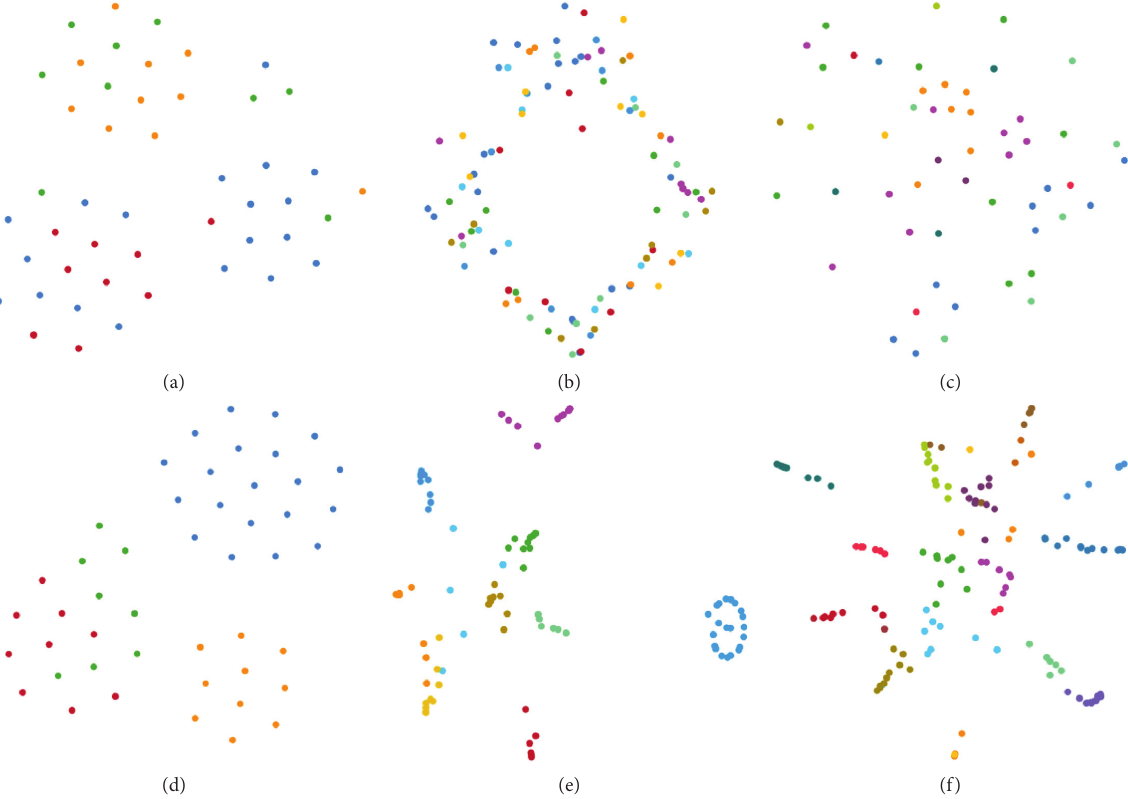
Figure 10: Visualization of the fault diagnosis results of GCNN and the SMOTE-SVM for different scenarios by t-SNE. (a) SMOTE-SVM four classes. (b) SMOTE-SVM ten classes. (c) SMOTE-SVM sixteen classes. (d) GCNN Case 7 four classes. (e) GCNN Case 7 ten classes. (f) GCNN case 7 sixteen classes.